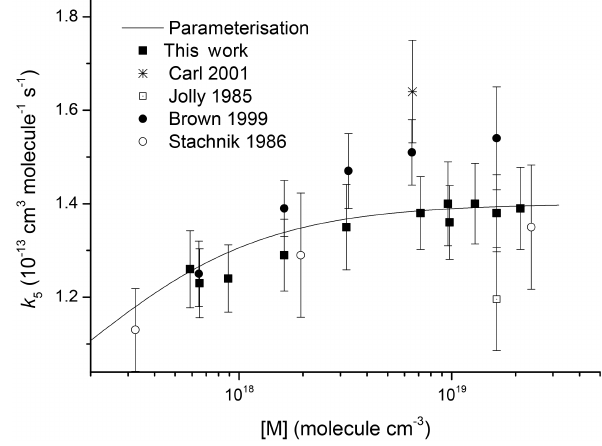
Figure 9. Comparison of room temperature rate coefficients ( k 5 ) obtained in nitrogen bath gas. The error bars on our data points rep- resent total uncertainty. The solid line are values of k 5 at 297K from the parameterisation obtained by fitting to the temperature- and pressure-dependent data sets from Brown et al. (1999), Stach- nik et al. (1986) and this